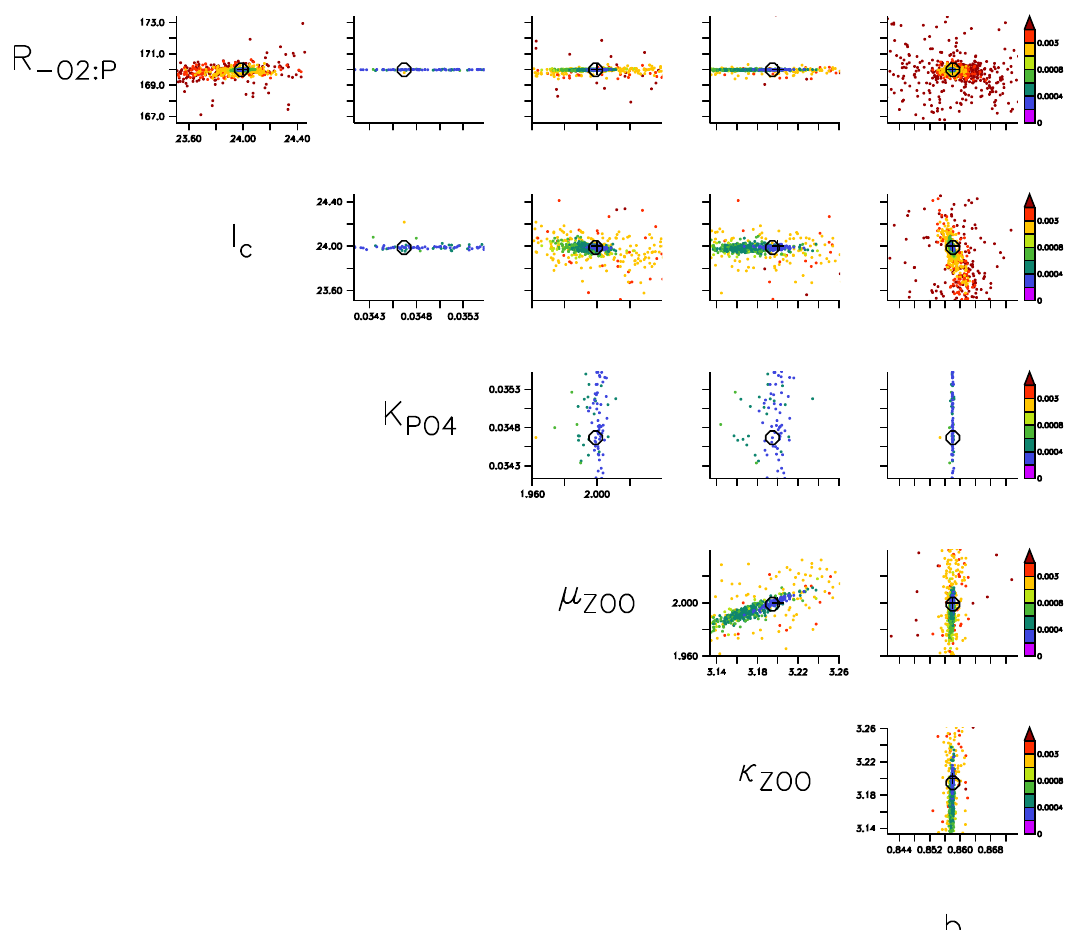
2% around the average parameter value of the last generation, regardless of generation Figure 6. As Fig. 5, but only plotted for a region ± and associated misfit. Note that these parameters can have occurred early in the optimization and even be associated with a large misfit (that would arise from at least one of the other parameters, causing a large misfit). Note that the color scale is different than in Fig.